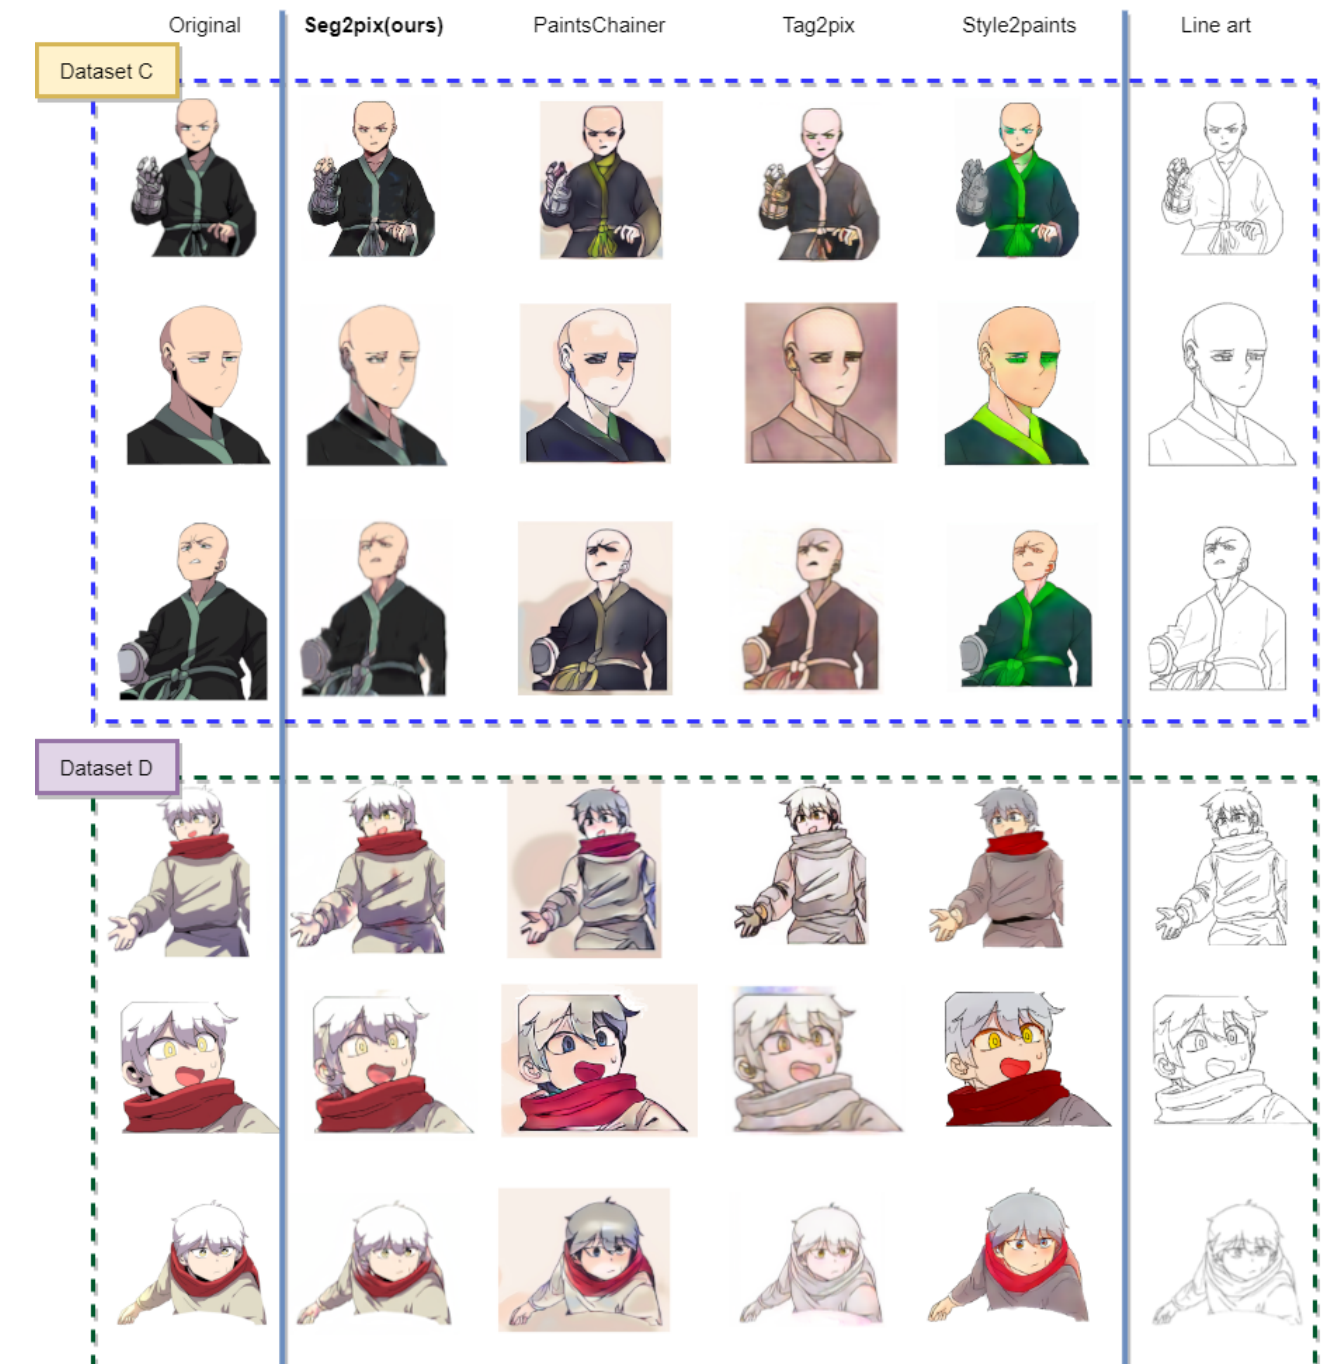
Figure 11. Comparison of the line art colorization results. The first column shows the original ground truth image. Columns 2–5 show the automatic colorization results; from left to right: Seg2pix, PaintsChainer (Canna) [6], Tag2pix [16], and Style2paints [7]. Rows 1–3 of the Seg2pix column are the results from the model trained on Dataset C (Fantasy sister series), and Rows 4–6 are the results from the model trained on Dataset D (Fantasy sister